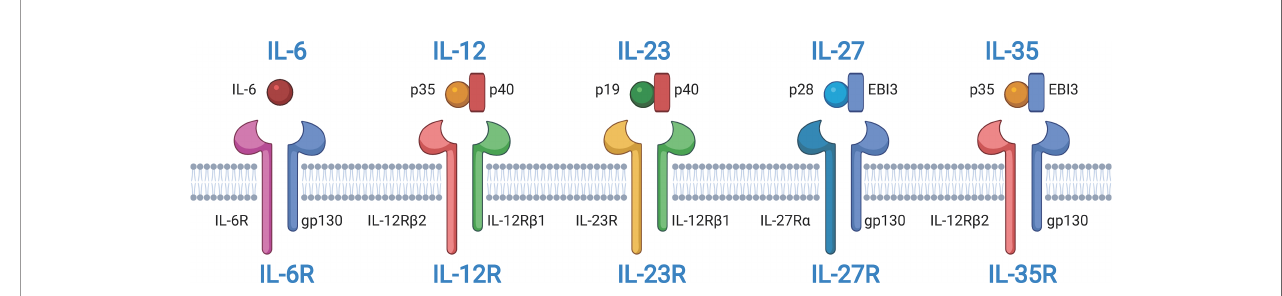
FIGURE 1 | Structures of interleukin-12 (IL-12) and IL-6 cytokine families and their receptors. IL-6, IL-12, IL-23, IL-27, and IL-35 belong to IL-12 and IL-6 cytokine families. IL-12, IL-27, and IL-35 are composed of two subunits. IL-12 and IL23 share the common subunit p40. IL-12 and IL-35 share the common subunit p35. IL- 27 and IL-35 share the common subunit Epstein-Barr virus induced 3 (EBI3). All receptors of IL-6, IL-12, IL-23, IL-27, and IL-35 are heterodimers. Some subunits are shared among receptors. IL-6R, IL-27R, and IL-35R share the common receptor subunit gp130. IL-12 and IL-23 share the common receptor subunit IL-12R b 1. IL-12R and IL-35R share the common receptor subunit IL-12R b 2. The fi gure was created with BioRender.com.